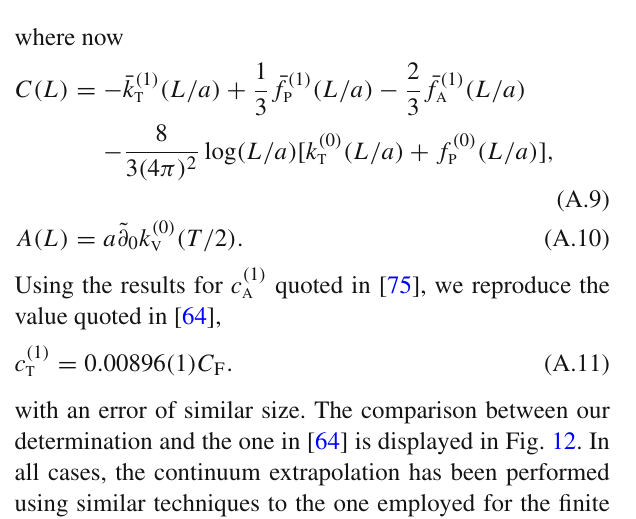
, compared with the result in T